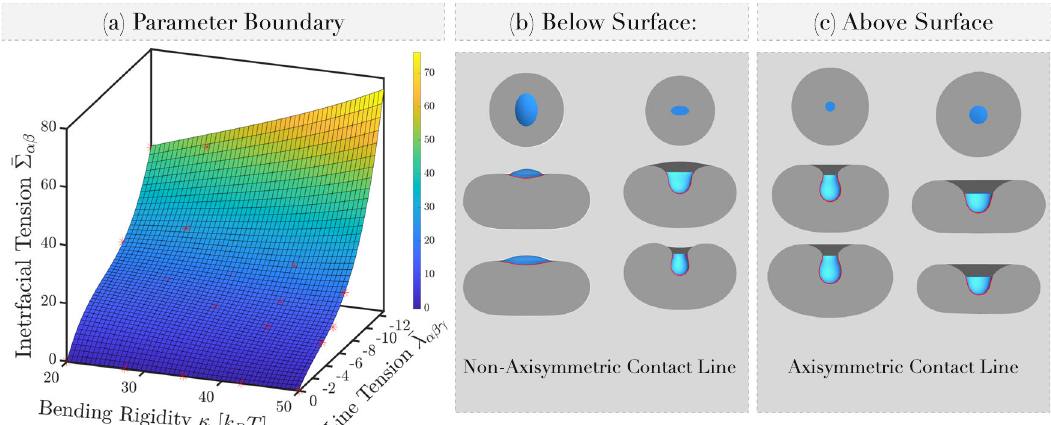
Fig. 4 Parameter boundary and geometry of three-phase contact line. ( a ) Boundary surface in the three-dimensional parameter space de fi ned by bending rigidity, interfacial tension and line tension: above this surface, the three-phase contact lines of the nanodroplet-vesicle are axisymmetric but non-axisymmetric below the surface. Red stars show the scanned data points. The surface is a polynomial (degree of three with two variables) fi t (cid:1) Σ fit ð (cid:1) λ ; κ Þ over the red data points, see Supplementary Note 8 for more details. The color of the surface represents the critical value of interfacial tension αβγ αβ (cid:1) Σ αβ . ( b , c ) The nanodroplet-vesicle shapes illustrate the morphology of nanodroplet endocytosis. The morphology of the nanodroplet-vesicle system with non-axisymmetric contact line geometry is observed below the boundary surface ( b ), while axisymmetric contact line geometries are observed above this surface ( c ). The panels in the top row of ( b ) and ( c ) show the top views of the elliptic and circular contact lines, respectively. The second and third rows show two cutaway views. The vesicle radius is R ve = 1 μ m, and volume-to-area ratio is v = 0.75, the spontaneous curvature is zero and relative size of nanodroplet to vesicle is r α = 0.22,